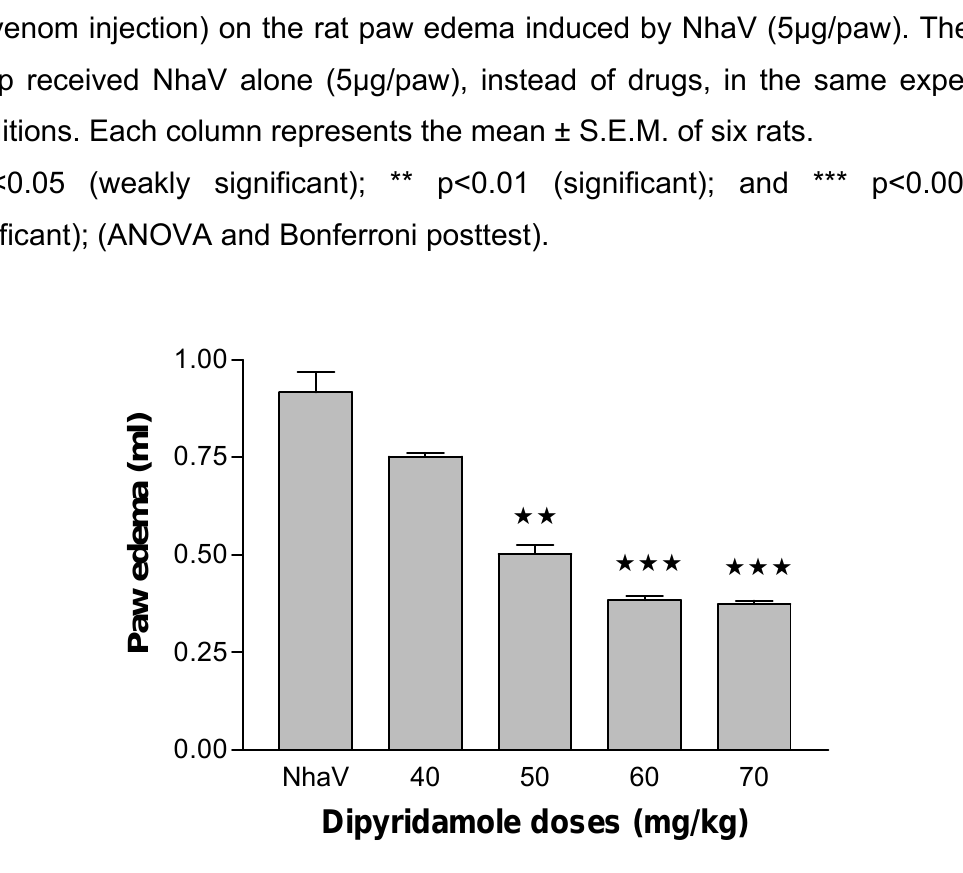
Figure 3: Effect of dipyridamole (40, 50, 60, 80mg/kg, i.p. administered 30 min before the venom injection) on the rat paw edema induced by NhaV (5µg/paw). The control group received NhaV alone (5µg/paw), instead of drugs, in the same experimental conditions. Each column represents the mean ± S.E.M. of six rats. * p<0.05 (weakly significant); ** p<0.01 (significant); and *** p<0.001 (very significant); (ANOVA and Bonferroni